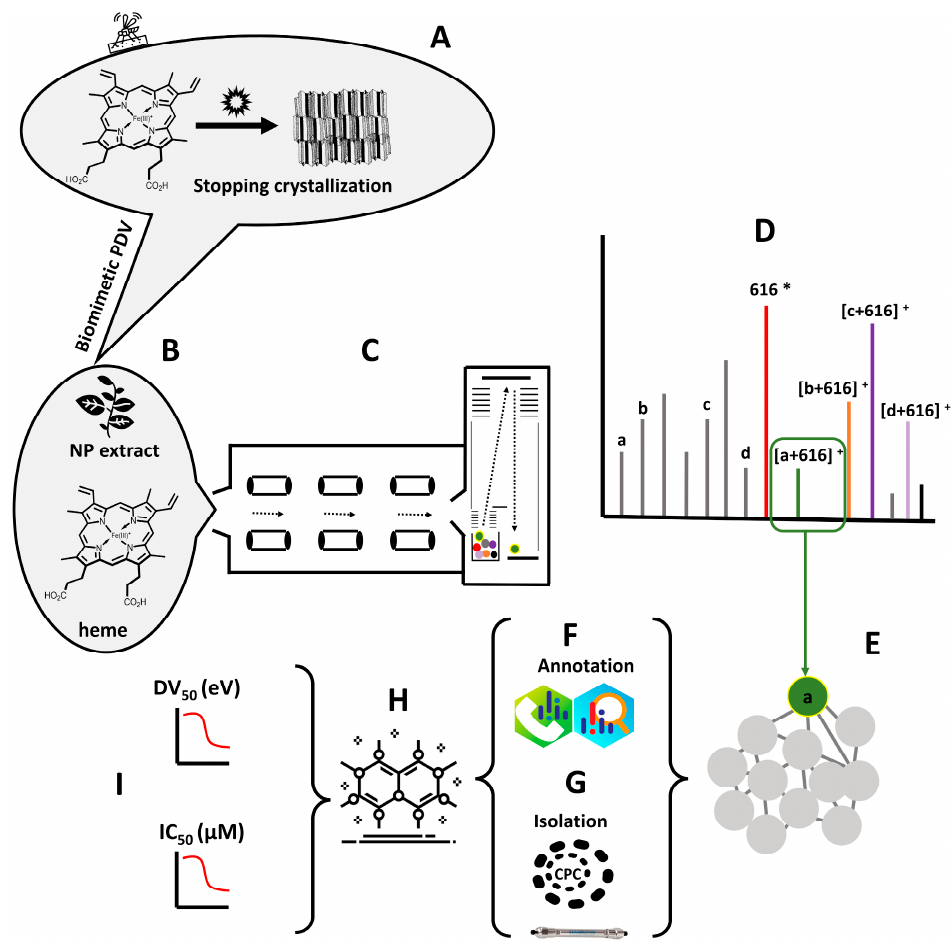
Figure 1. Biodereplication workflow. Schematization of the mechanism of action of antimalarial drugs based on the inhibition of the crystallization pathway of free heme (Fe(III)PPIX) ( A ). Mixture of heme and a natural extract in a biomimetic Plasmodium digestive vacuole (PDV) solution ( B ). Heme-binding assay by mass spectrometry (MS) using a QToF instrument in infusion mode ( C ). Total ion current (TIC) chromatogram displaying masses providing adducts in positive ionization mode ( D ). In D , a, b, c, and d = compounds present in the extract. Molecular networking of infusion mode showing adducts of targeted mass, i.e., [a + 616] + . Molecular networking is also used to identify targeted mass in LC–MS data from the NP extract ( E ). Comprehensive annotation of targeted mass using MS-Dial and MS-Finder guided by dedicated databases ( F ). Compound isolation of targeted mass using centrifugal partition chromatography (CPC) and preparative HPLC ( G ). Chemical characterization of isolated compounds ( H ). Pharmacological validation of isolated compounds: Heme-binding strength (expressed as DV 50 ) and in vitro biological activity (expressed as IC 50 ). NP = Natural product; * [heme] + = 616 ( I ).